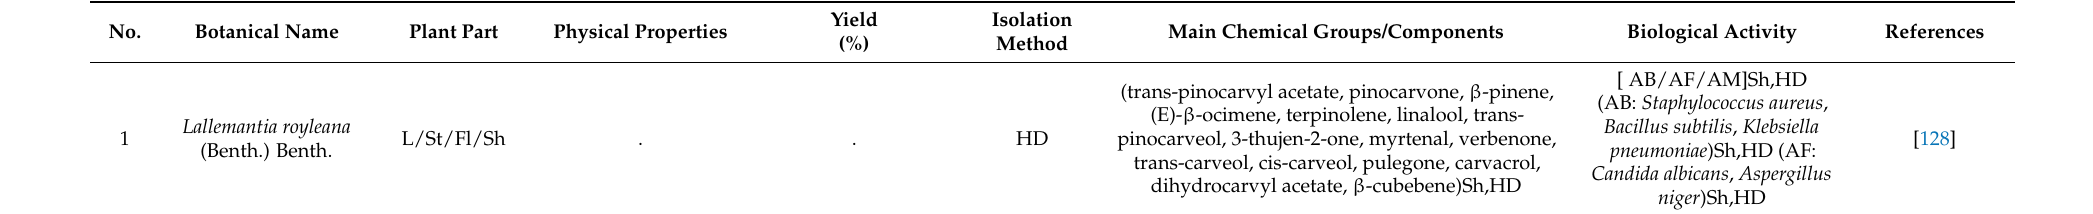
Table 10. Details of EOs isolated from species of